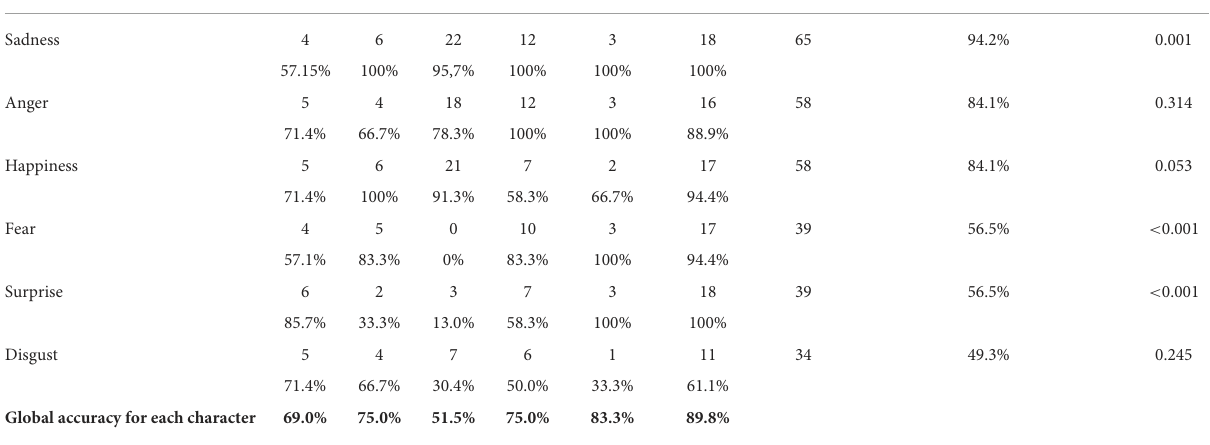
TABLE 2 Accuracy in identifying each emotion and the overall accuracy by